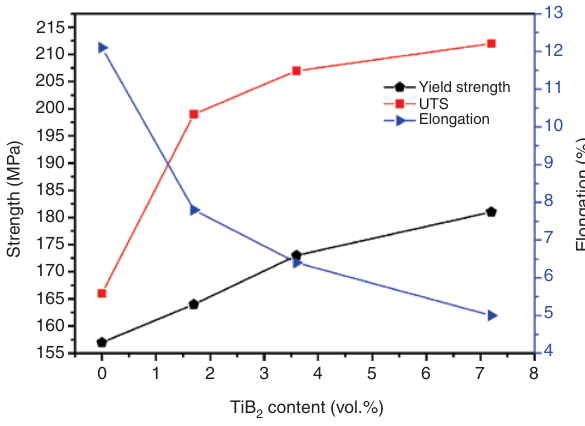
content on the tensile mechanical 2